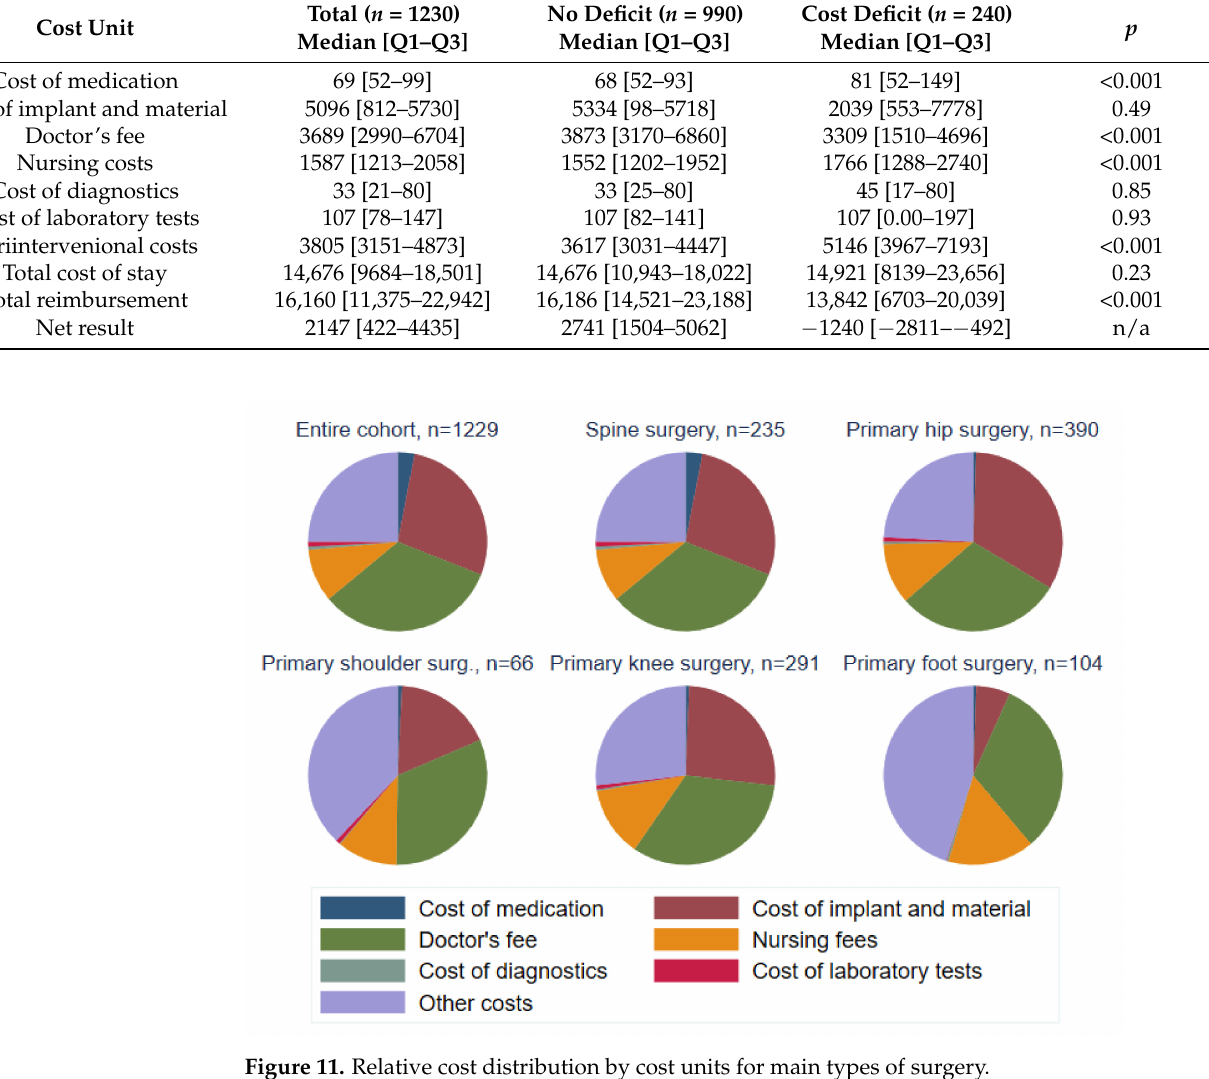
Table 4. Overview of cost units (in CHF), including median costs for each unit for no deficit and the cost deficit groups, and relative p -values.